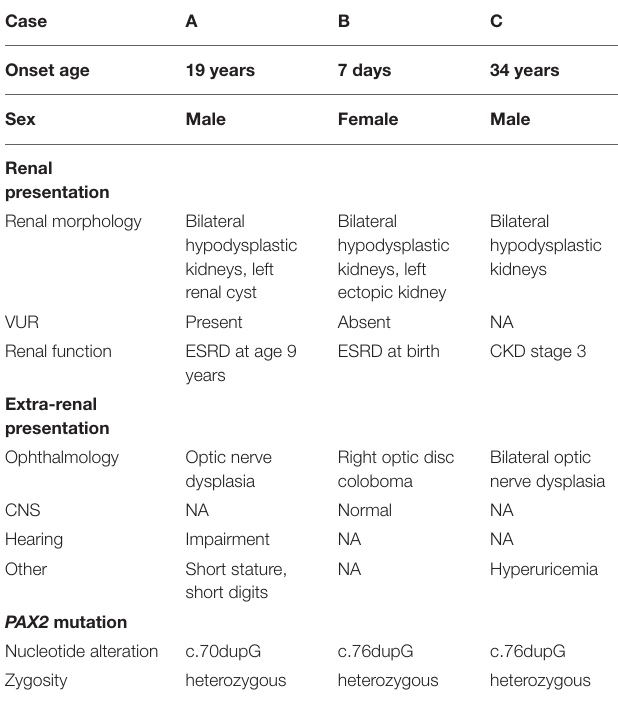
TABLE 1 | Summary of the three